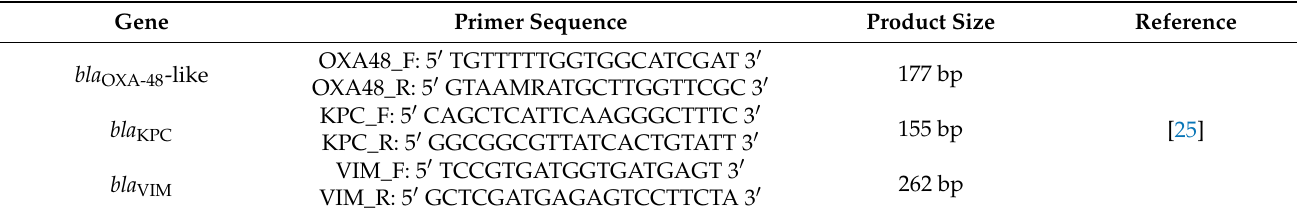
Table 5. Primers used for detecting carbapenemase-encoding genes by